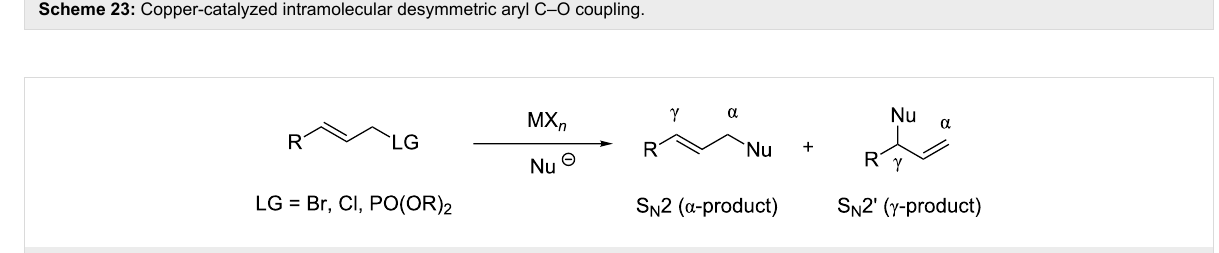
Scheme 24: Transition metal-catalyzed allylic